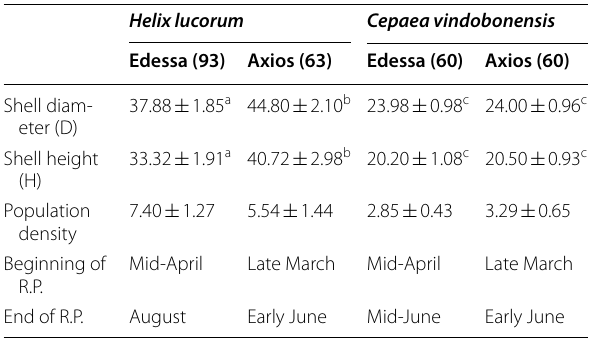
Table 1 Shell diameter (D), shell height (H) (mean population density (adults m − 2 ), and timing characteristics of the reproductive period (R.P.) of Helix lucorum and Cepaea vindobonensis from the two study sites, Edessa and Axios. Number of individuals is given in parenthesis